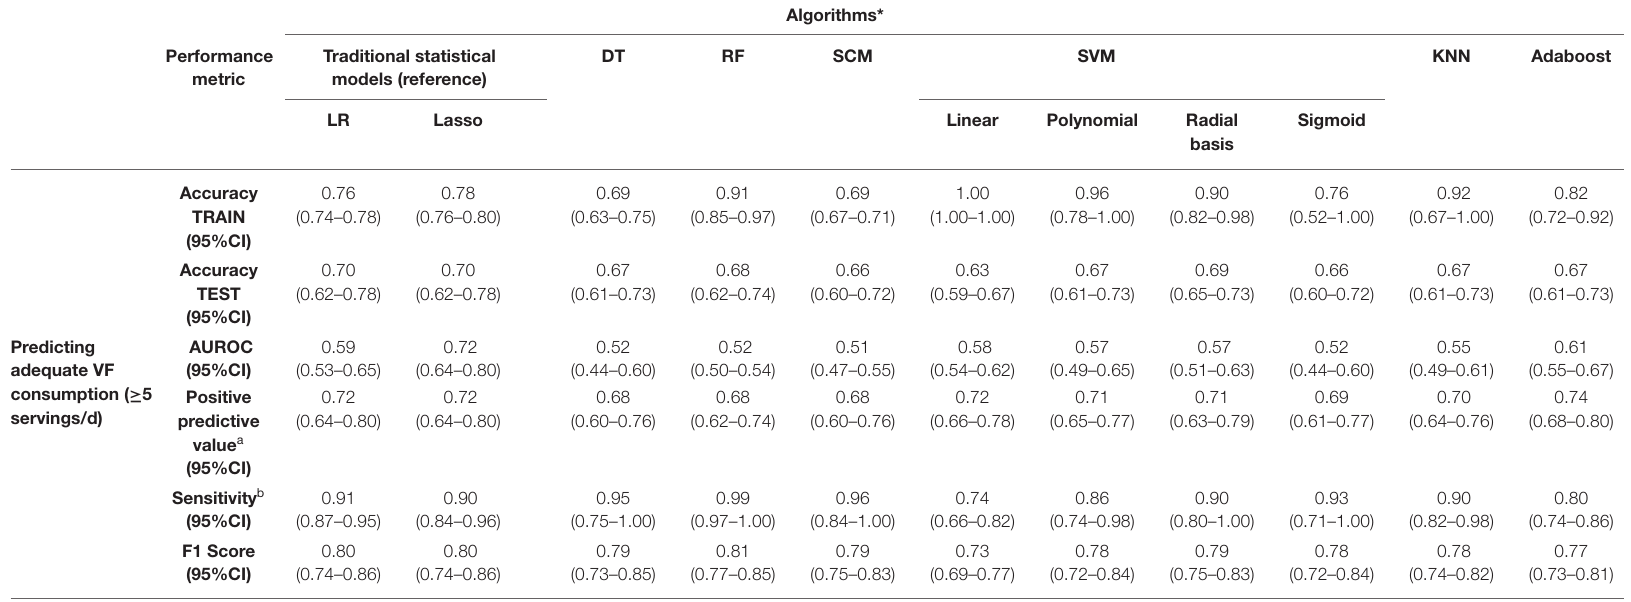
TABLE 5 | Performance metrics of two traditional models and nine machine learning algorithms to predict adequate vegetable and fruit (VF) consumption based on dietary intake data obtained from a web-based food frequency questionnaire (wFFQ) among1147 French-speaking adults from Québec,